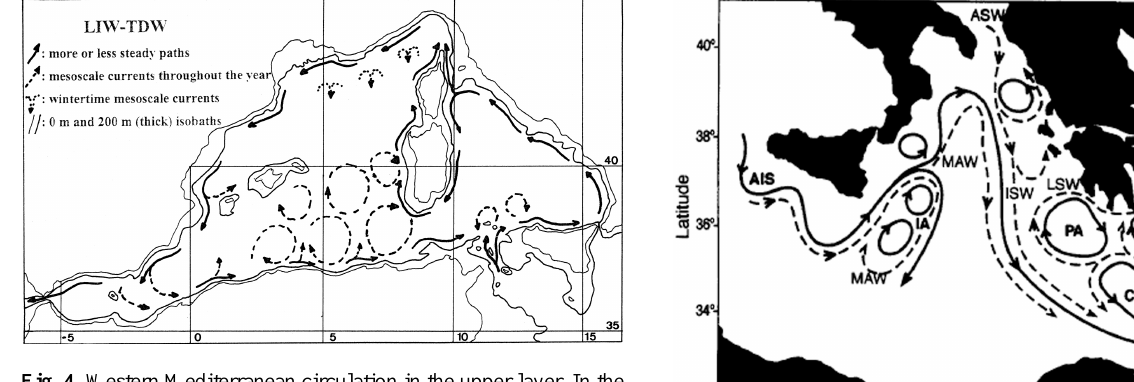
Fig. 4. Western Mediterranean circulation in the upper layer. In the northern part of the WMed, the westward rim current is permanently well defined, even if affected by seasonal variability. This AW flow is a recirculating branch that detaches AW from southern latitudes in the southwestern area of Sicily (Millot and Taupier-Letage, 2005). In the southern part of the WMed the Algerian Current is unstable and generates (anticyclonic) meanders and eddies of ∼ 50–100km (up to 200) in diameter. These eddies can detach from the Algerian current and propagate into the interior of the Algerian and Tyrrhe- nian basins. The pattern of Fig. 4 has recently been extended to the entire Mediterranean by Millot and Taupier-Letage (2005), who have inferred it from SST imagery. In the EMed, however, and es- pecially in the Levantine Basin (or Levantine Sub-Basin, LSB, as in Menna et al., 2012), the AW is topped by the more saline Levantine surface waters during most of the year and the use of SST imagery to infer circulation patterns is rather controversial.